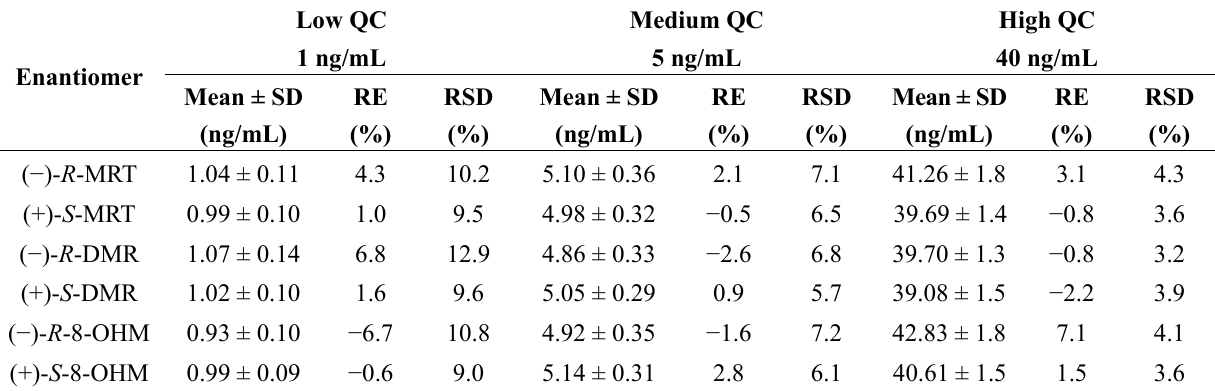
Table 3. Between-day precision and accuracy for the analysis of MRT, DMR and 8-OHM enantiomers in human plasma (n = 15).